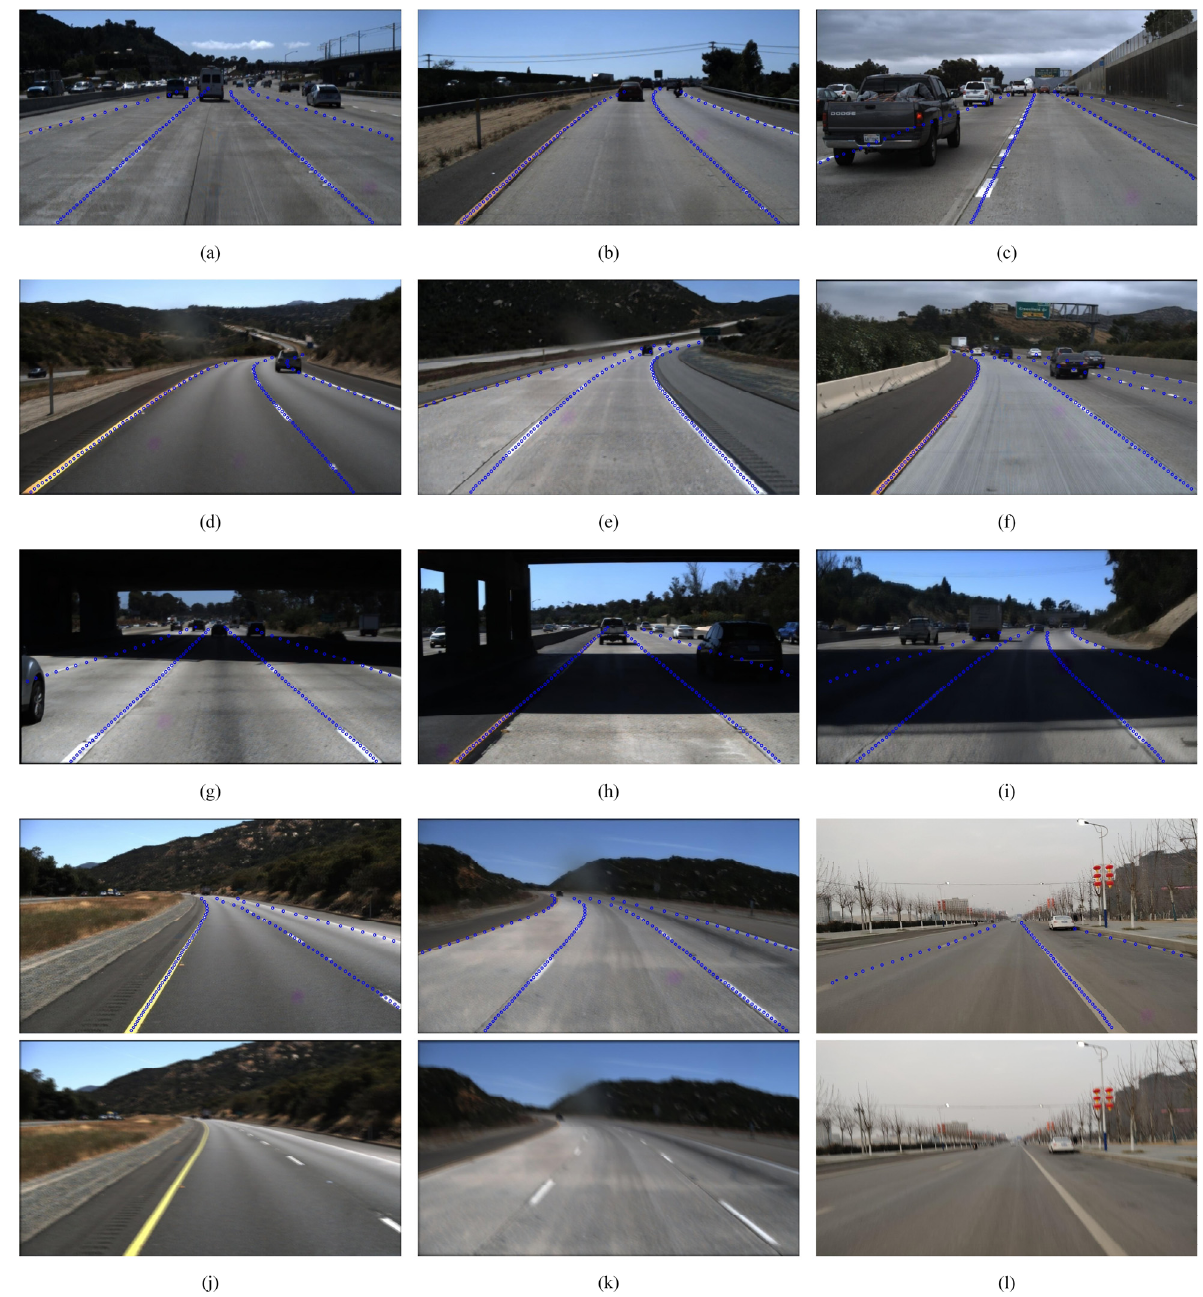
Figure 7. Display the results of Lane-GAN in our dataset. ( a – c ) are the detection results when the lane lines are severely worn, the continuous line segment is short, and the lane lines are occluded; ( d – f ) present the detection results in the cases of curved lane lines; ( g – i ) display the detection results in the cases of shading; the first row in ( j – l ) is the detection results of blurred images, and the second row shows the images after enhancement of blurred features.